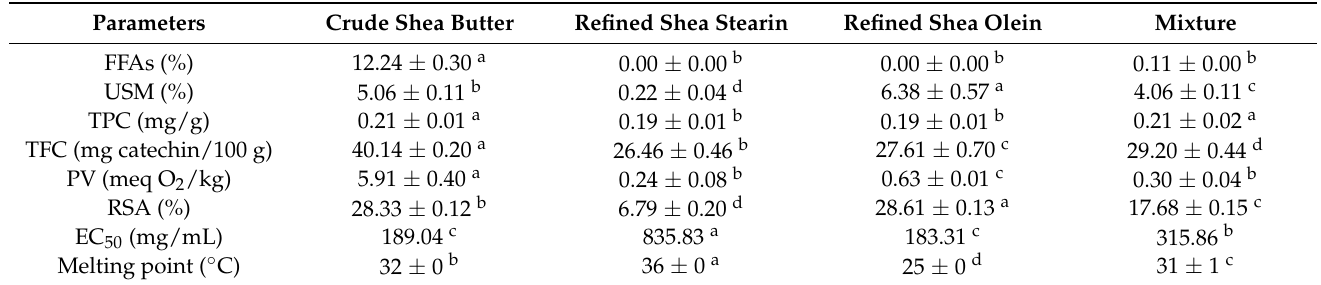
Table 3. Physicochemical characteristics and oxidative stability parameters of crude shea butter, refined shea stearin, refined shea olein and a mixture of olein:stearin (1:1 w / w ). Crude Shea Butter Refined Shea Stearin Refined Shea